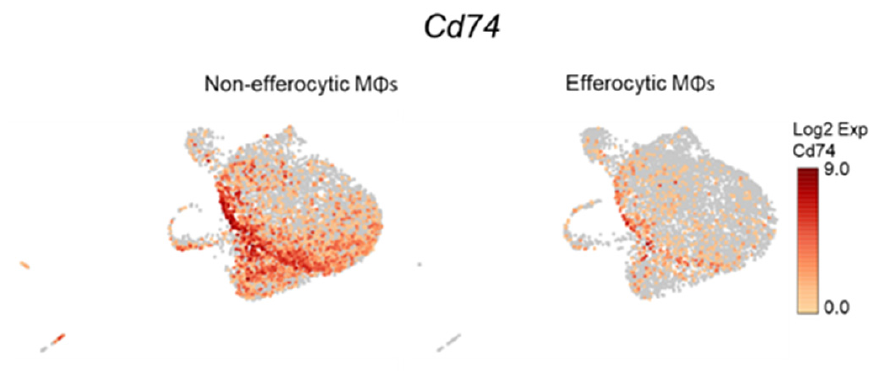
Figure A11. Single-cell plots of Cd74 expression in efferocytic BM macrophages. scRNA-Seq analysis plots show Cd74 distribution in efferocytic and non-efferocytic (control) clusters of BM macrophages (M Φ ) corresponding to Experiment 1 in Figure